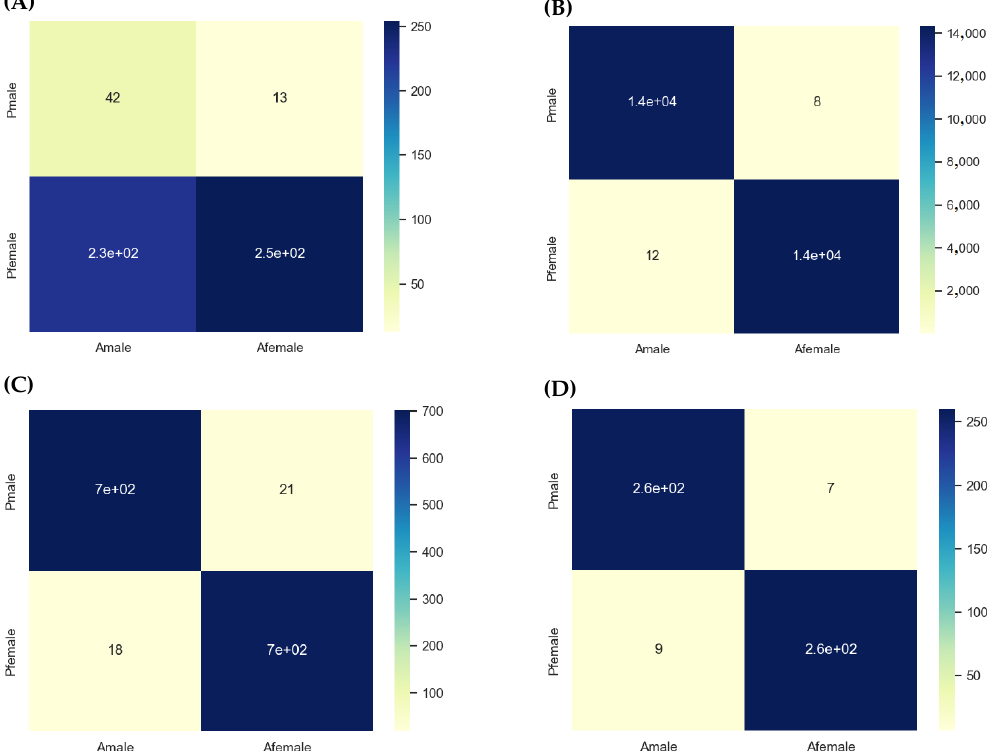
Figure 7. Confusion matrices of SGR methods tested on different datasets ( A ) Confusion matrix of SGR method from [23] trained on RAVDESS and tested on EMO-DB. ( B ) Confusion matrix of our SGR method trained on LibriSpeech. ( C ) Confusion matrix of our SGR method trained on LibriSpeech and tested on RAVDESS. ( D ) Confusion matrix of our SGR method trained on LibriSpeech and tested on